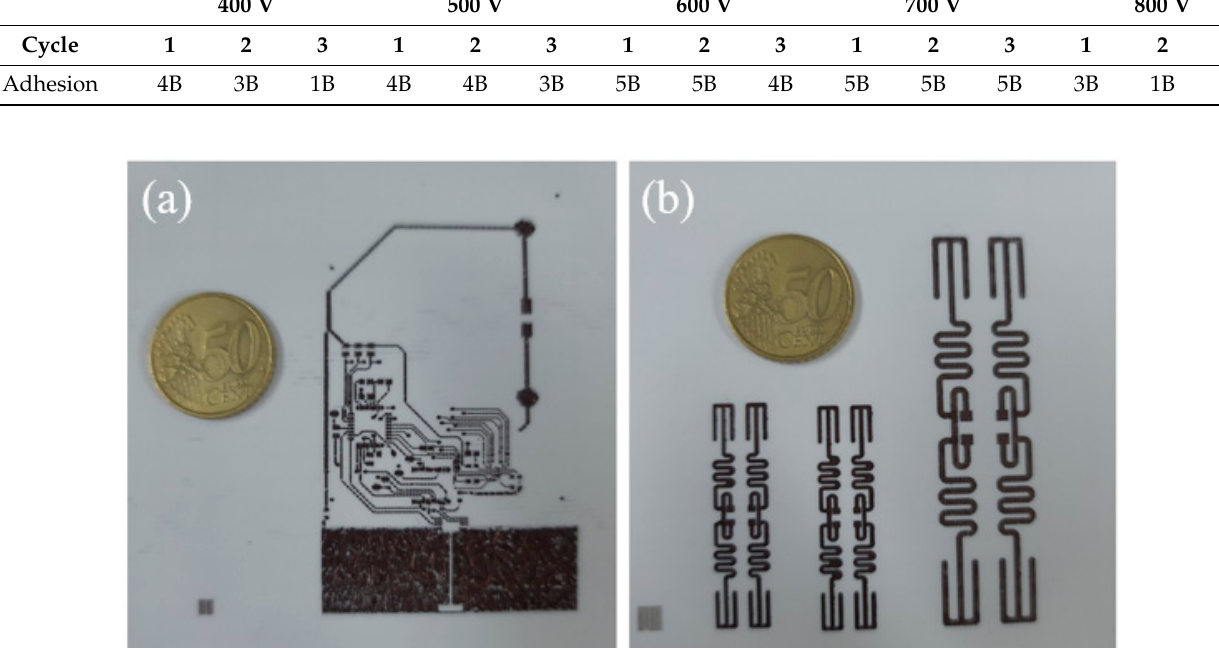
Figure 12. Photograph of ink-jet 3D printed complex structures with photo-cured SiO 2 ink and IPL sintered Cu ink. The pattern of Cu ink is ( a ) PCB circuit ( b ) antenna circuit.